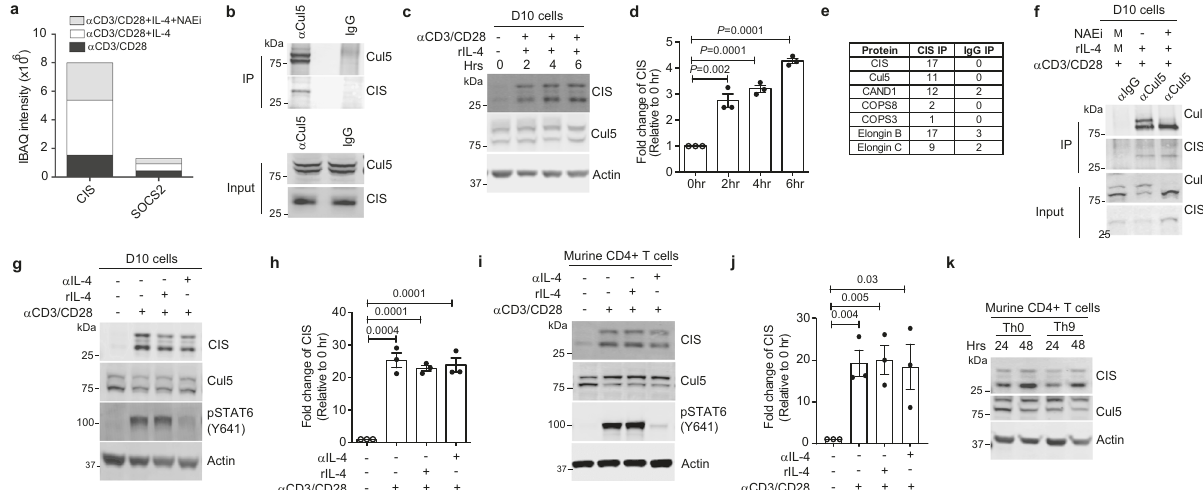
Fig. 4 CIS (Cytokine inducible SH2 protein) acts as a substrate receptor for CRL5. a IBAQ intensities for CIS and SOCS2 proteins. CD4 + T cells from 8 – 10-week-old mice were restimulated for 4 h with either anti-CD3 and anti-CD28, or anti-CD3 and anti-CD28 in the presence of IL-4, or anti-CD3 and anti-CD28 in the presence of IL-4 and treated with Neddylation inhibitor (NAEi) for the fi nal one hour. After the respective treatment, the lysates were immunoprecipitated by anti-Cul5 or IgG antibodies, and samples were analyzed by mass spectrometry. n = 2 biologic replicates of cells examined in two independent experiments. b Immunoblot showing interaction of Cul5 and CIS in primary CD4 + T-cells. n = 2 biologic replicates of cells examined in two independent experiments. Representative Immunoblot ( c ) and fold change in CIS expression ( d ) in D10 cells. n = 3 biologic replicates of cells examined in three independent experiments. To calculate fold change, the normalized CIS level at 0 h was adjusted to 1 and the relative change in the expression of CIS protein was calculated accordingly. e Table showing components of the CRL5 E3 ubiquitin complex that were identi fi ed by CIS IP and IgG IP in D10 cells. Cells were stimulated in the presence of IL-4 and NAEi for 4 h. Total number of peptides identi fi ed in IP is listed in the table. n = 2 biologic replicates of cells examined in two independent experiments. f Immunoblot of Cul5 IP showing its interaction with CIS in D10 cells. n = 3 biologic replicates of cells examined in three independent experiments. Immunoblot ( g ) and fold change ( h ) of CIS in D10 cells stimulated in the presence of exogenous IL-4 or anti- IL-4 for 4 h. n = 3 biologic replicates of cells examined in three independent experiments. Immunoblot ( i ) and fold change of CIS protein ( j ) in murine CD4 + T-cells isolated from 8 – 10-week-old mice. n = 3 biologic replicates of cells examined in three independent experiments. k Immunoblot showing expression of CIS protein in murine CD4 + T cells. n = 3 biologic replicates of cells examined in three independent experiments. Data is presented as Mean± SEM in panels d , h and j . p- value was calculated using unpaired two tailed t- test. Source data are provided as Source Data fi